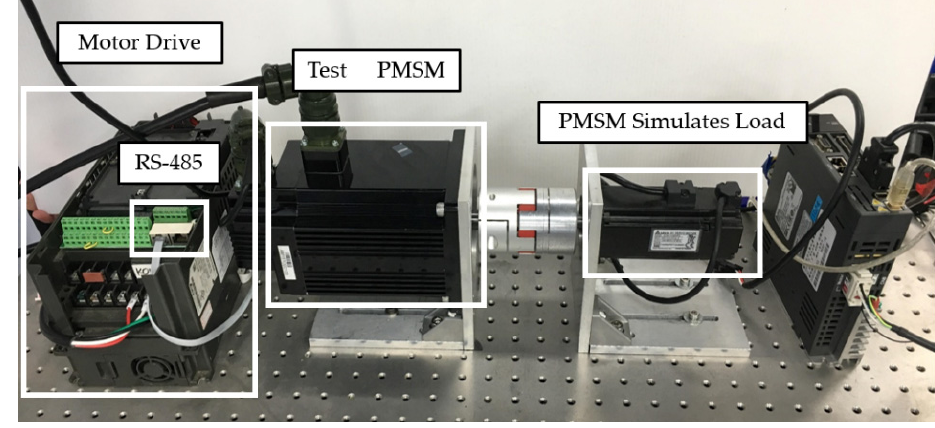
Figure 3. Experimental setup for collecting data.